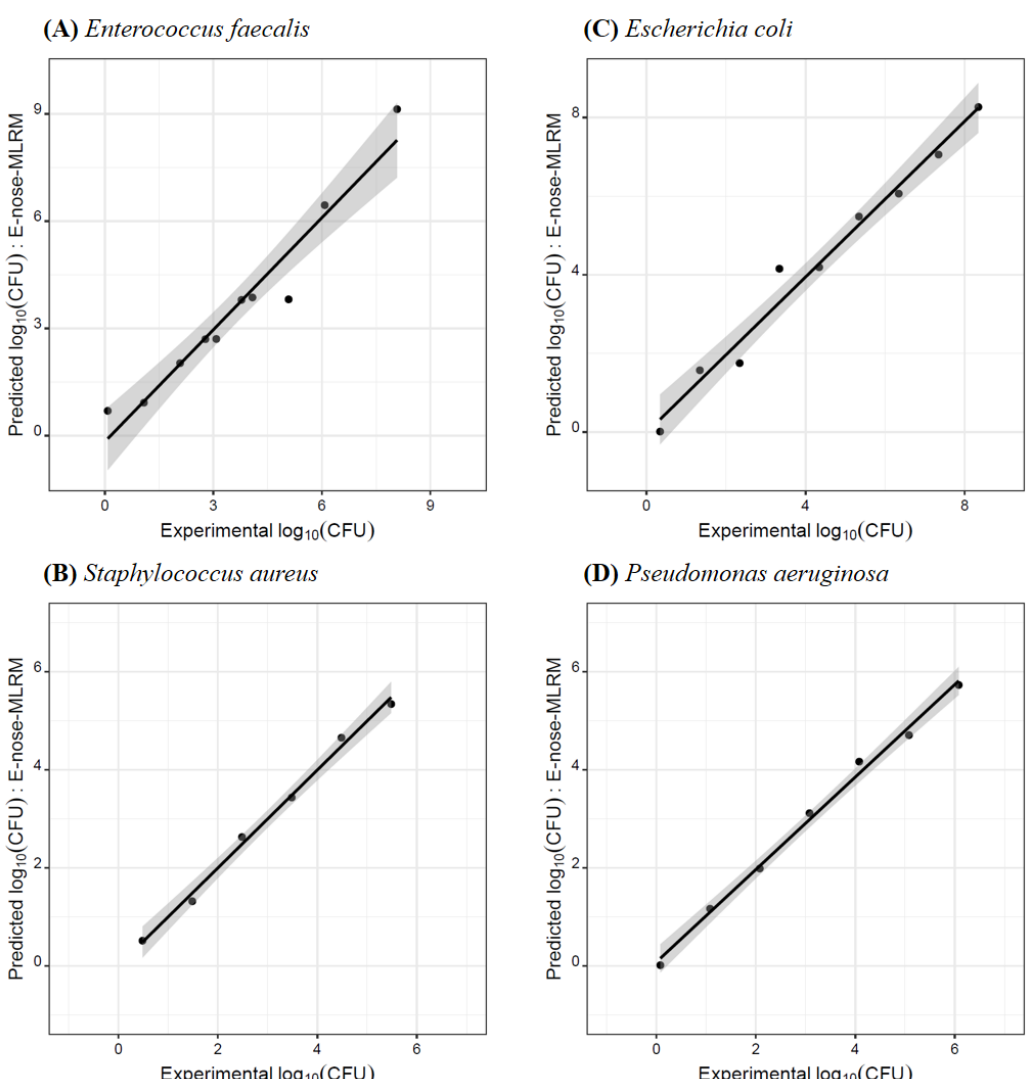
Feature extracted parameters from the E-nose-MOS response, selected by the SA algorithm and in- cluded in each MLRM. c R 2 : determination coefficient; RMSE: root mean square error.